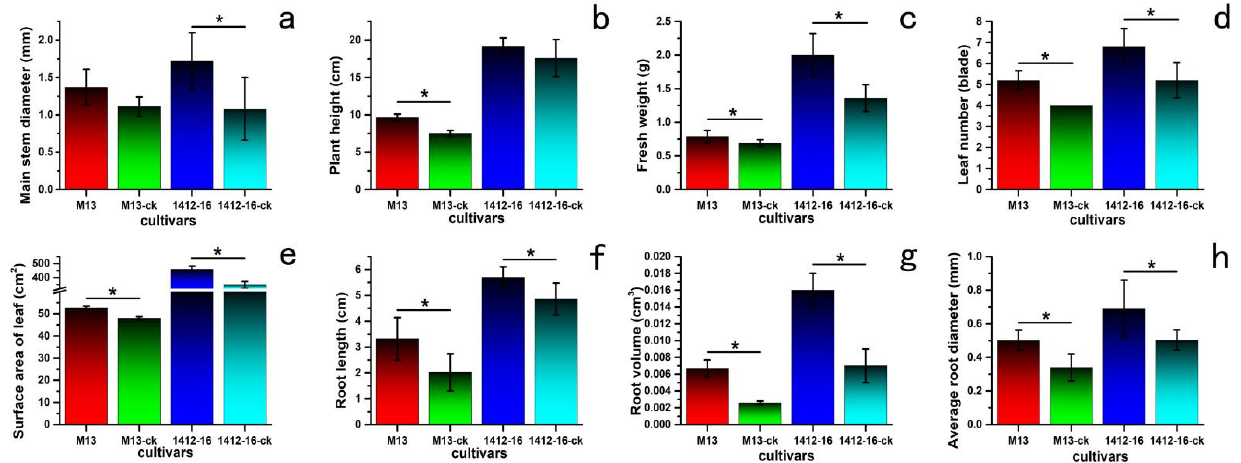
Figure 6. The impact of I. cateniannulata on the growth of two buckwheat varieties, F. tataricum No.M13 and F. esculentum 1412-16. at 10 d after foliar spraying. Note: significant differences between treatment group and control group were compared by one-way ANOVA. Significant differences at p < 0.05 were marked as single (*). The data were calculated using ten replicate assays. ( a ) main stem diameter; ( b ) plant height; ( c ) fresh weight; ( d ) leaf number; ( e ) surface area of leaf; ( f ) root length; ( g ) root volume; ( h ) average root diameter. ck: control group. Table 1. The impact of I. cateniannulata on the growth of different buckwheat cultivars at 10 d after foliar